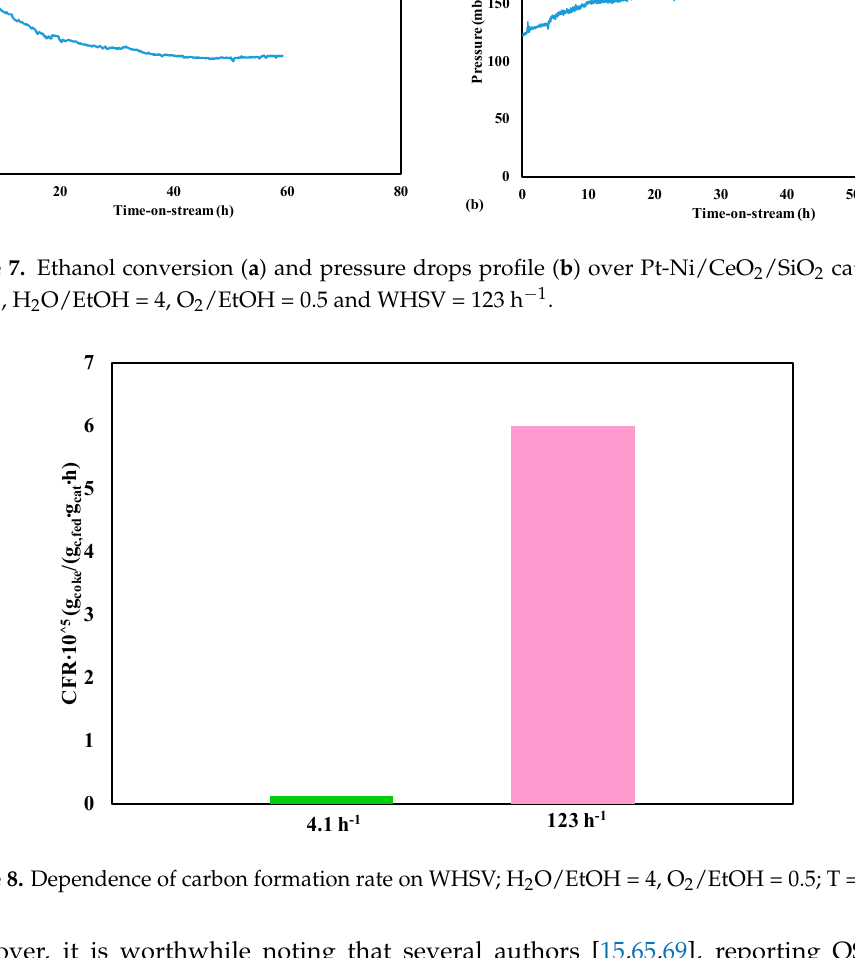
2 O/EtOH = 4, O 2 /EtOH = 0.5; T = 500